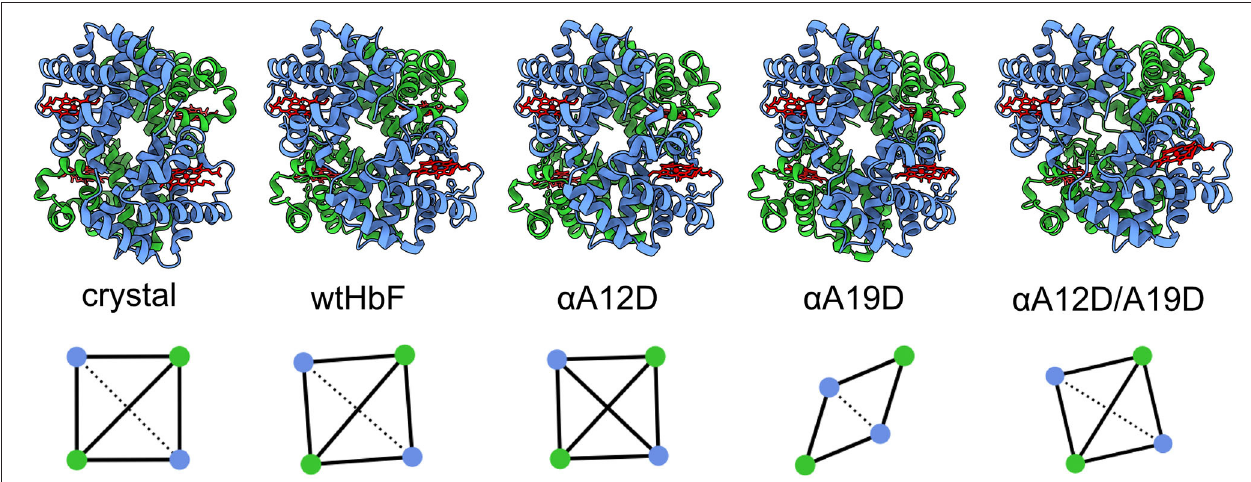
FIGURE 5 | The crystal structure of pdb ID 4MQJ (Soman and Olson, 2013) and four 3D models of the recombinant HbFs generated by the rigid-body docking. The α -subunits are displayed in blue and the γ -subunits in green, while the heme groups are red. Below, the chain-chain diagrams calculated by ChimeraX software are shown for the different structures generated by the rigid-body docking (SASREF, contact condition 7 Å). From left to right: crystal structure wtHbF, in solution SAXS of wtHbF, α A12D, α A19D, and α A12D/A19D. Blue dots are the α -chains, and green dots are the γ -chains. The solid lines show major interface areas ≥ 300 Å 2 , and the dotted lines show minor interface